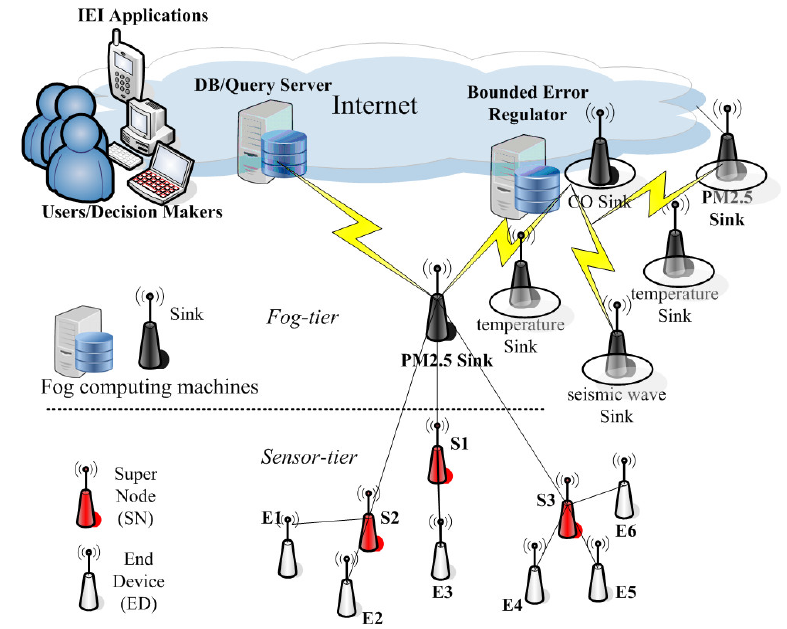
Figure 1. The proposed 2-tier system architecture for energy-efficient IEI applications.